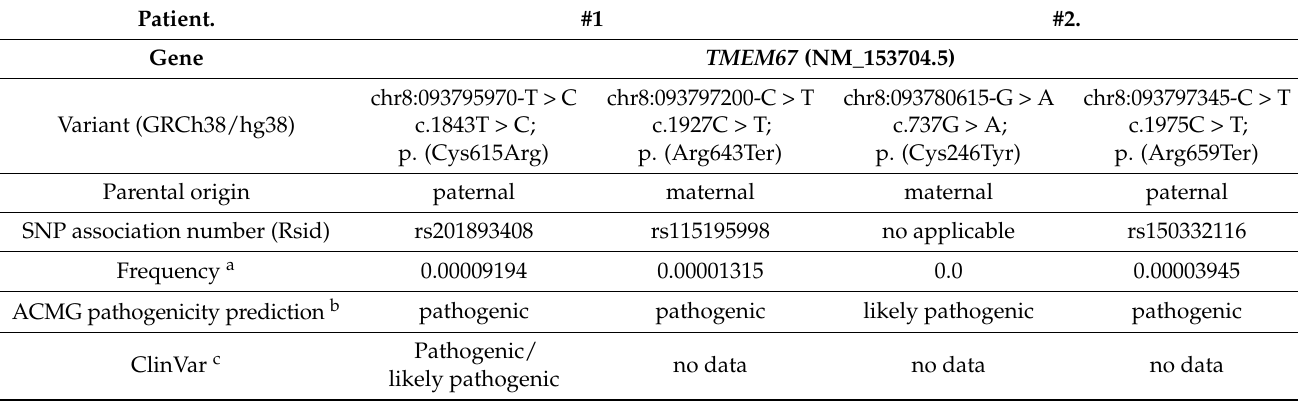
Table 1. Characteristic of TMEM67 variants identified in examined